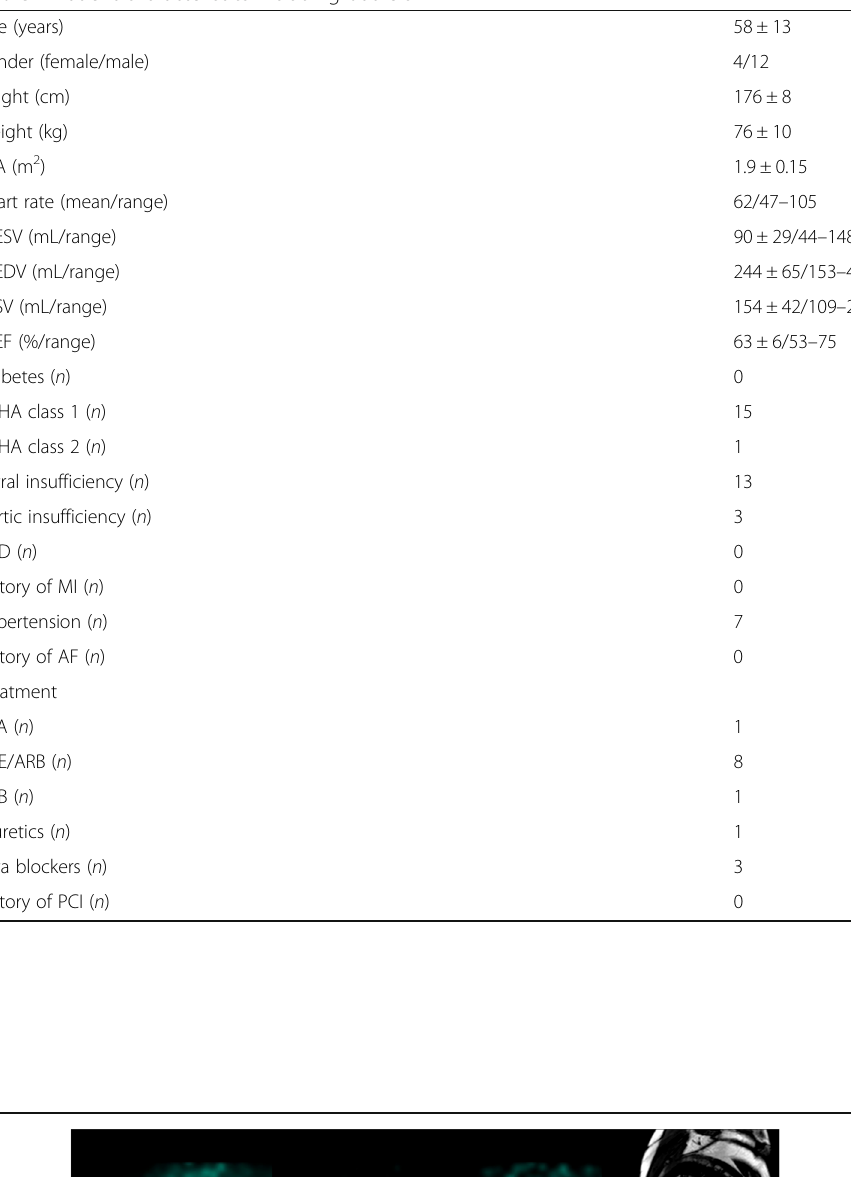
Table 1 Patient characteristics including outliers